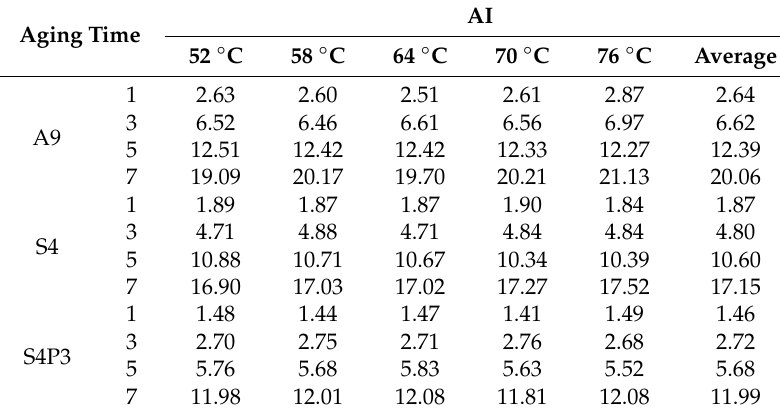
Table 3. Aging index (AI) at di ff erent aging times and temperatures.